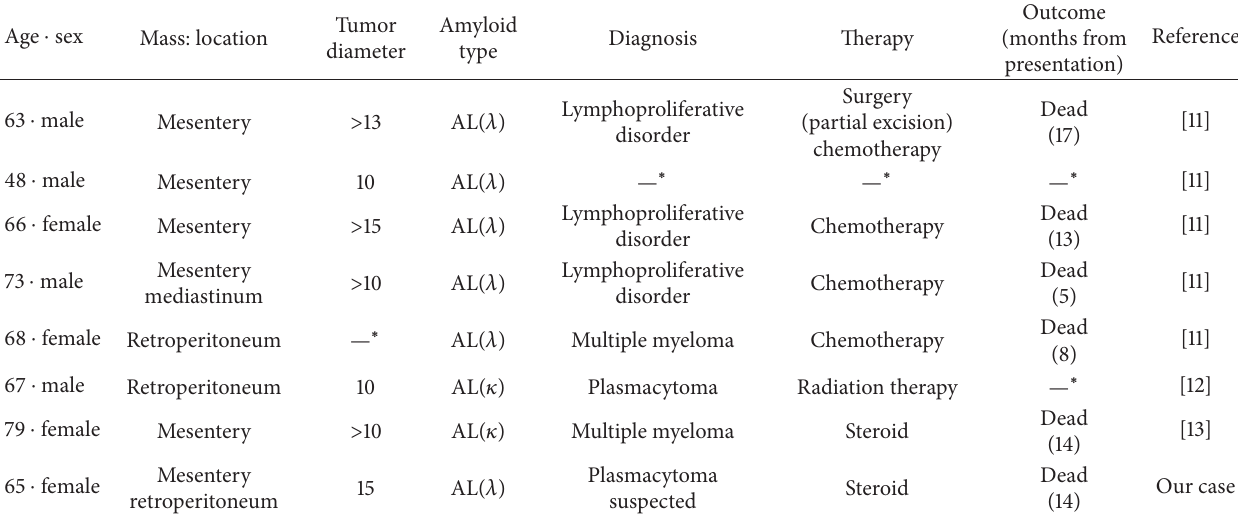
Table 1: Case reports of abdominal aortic retroperitoneal and mesenteric amyloid light chain